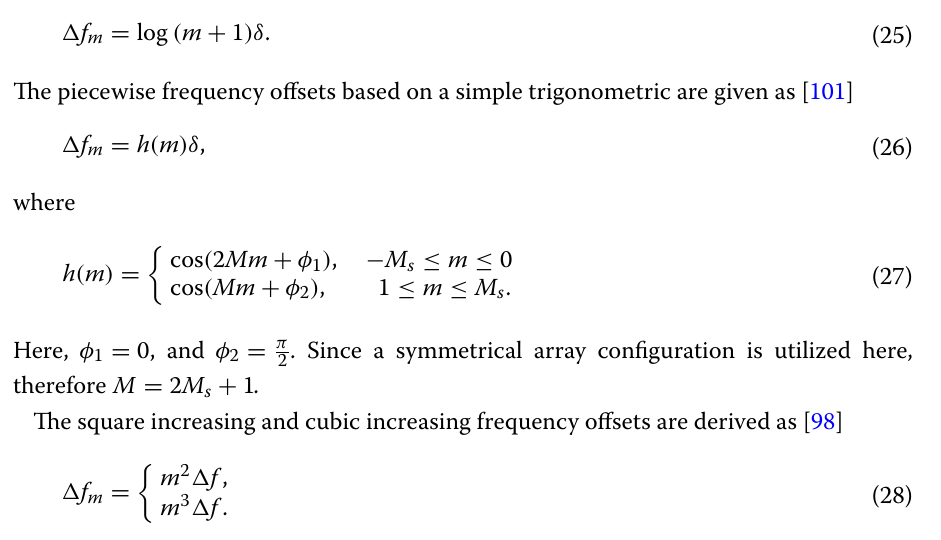
The piecewise frequency offsets based on a simple trigonometric are given as [101]